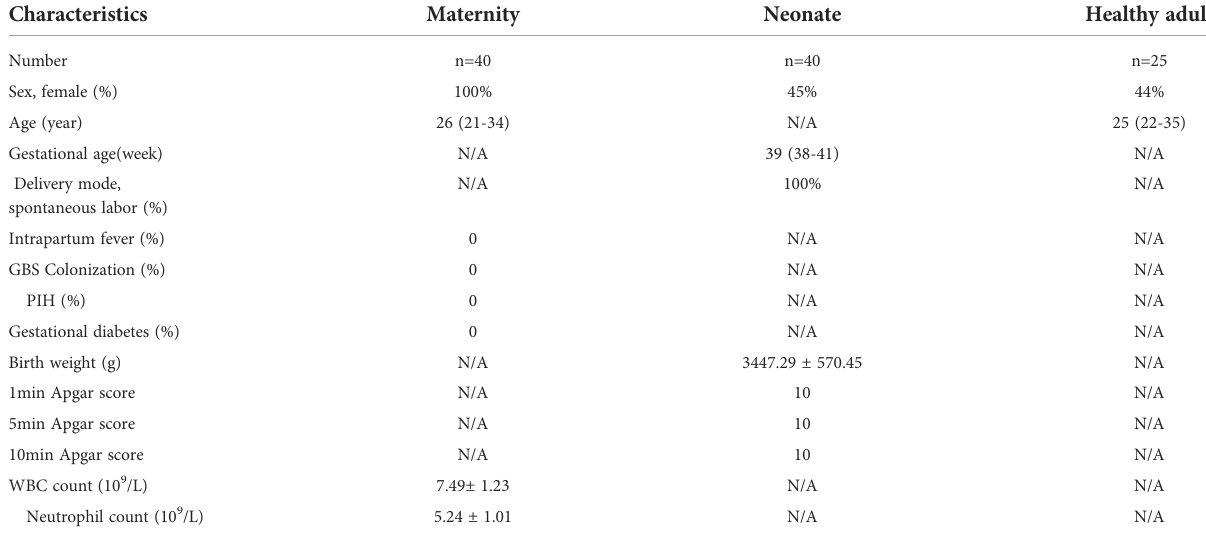
TABLE 1 Clinical data of UCB (including maternity and neonate) and healthy adults submitted for